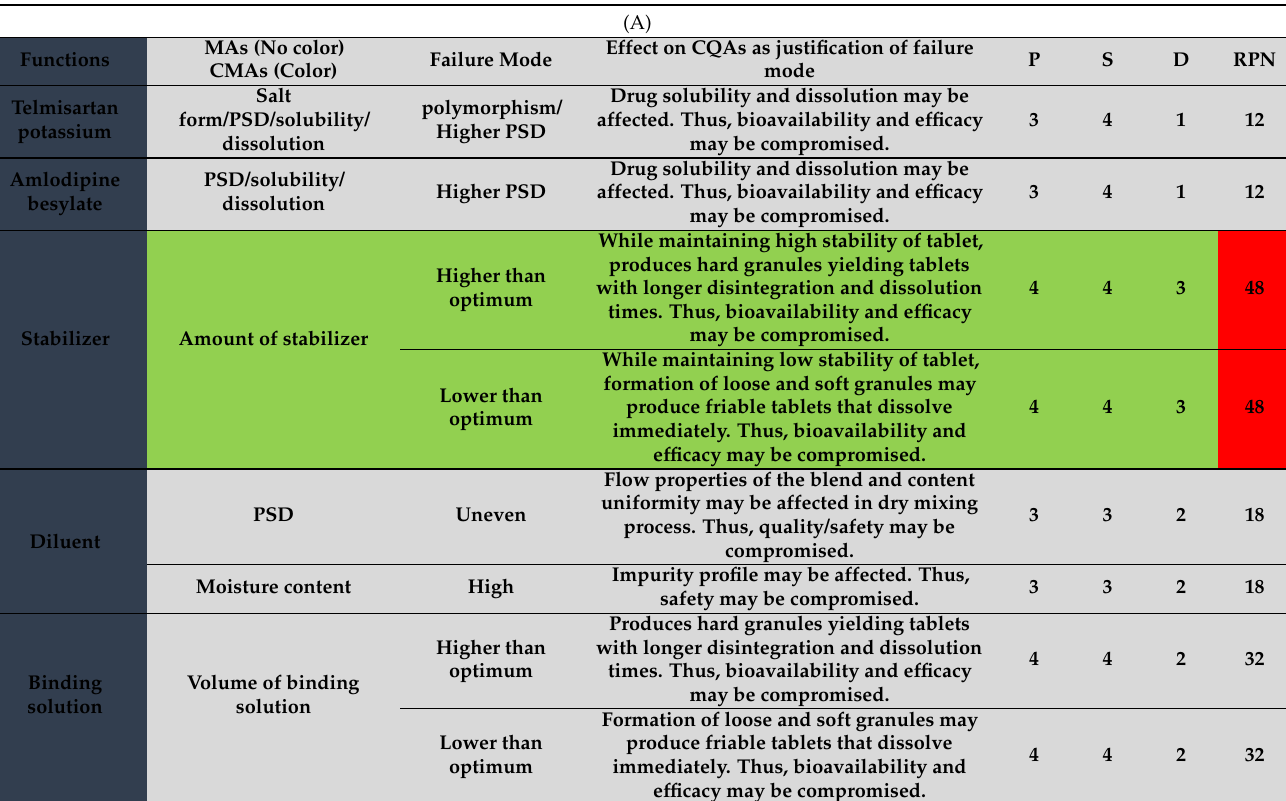
Table 1. Main risk assessment of the critical material attributes (A) and critical process parameters (B) affecting critical quality